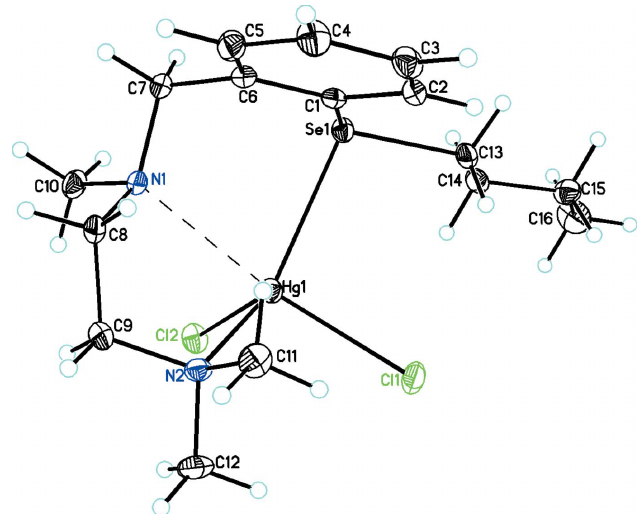
Figure 1 The molecular structure of { N 1 -[2-(Butylselanyl)benzyl]- N 2 , N 2 -dimethyl- ethane-1,2-diamine}dichloridomercury(II). The interaction between Hg1 and N1 is shown with a dashed line. Anisotropic displacement parameters are at the 30% probability